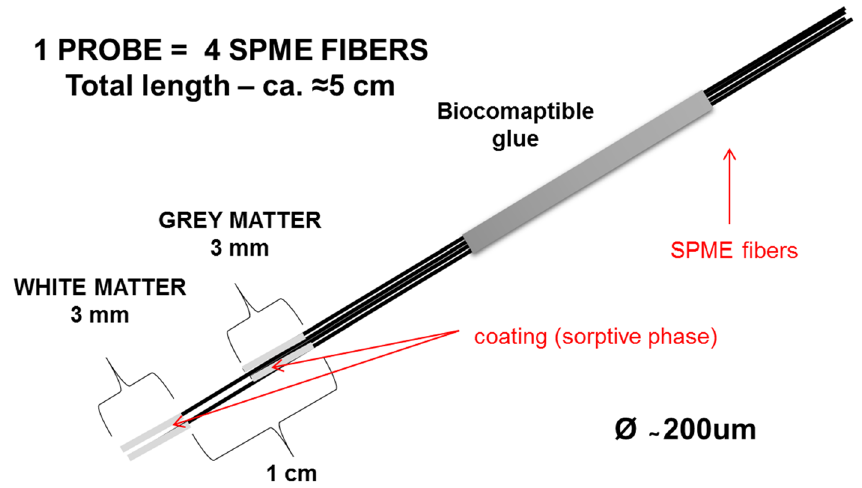
Figure 1. The construction of chemical biopsy